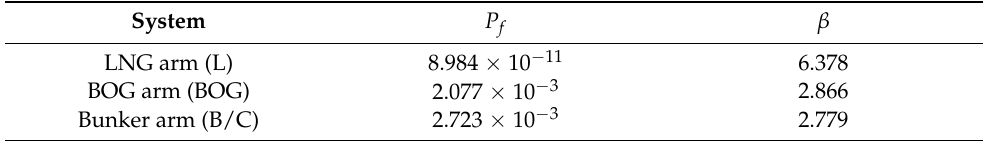
Table 12. Failure probability and corresponding reliability index of the ULA